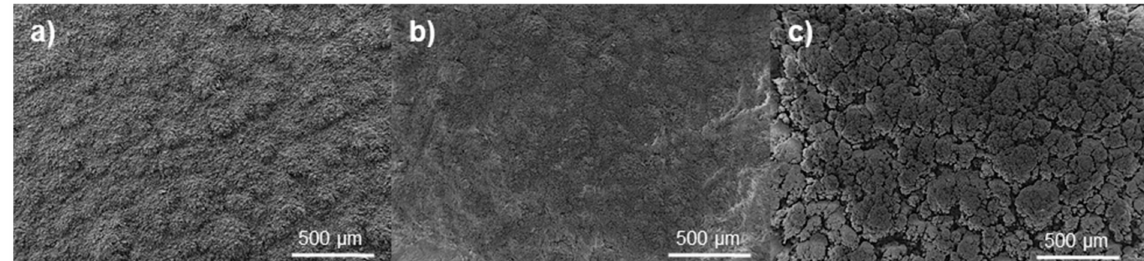
Figure 1. Surface micrographs of different suspension plasma spraying (SPS) coatings: ( a ) Al 2 O 3 /TZ-3YS; ( b ) SiC-reinforced Al 2 O 3 /TZ-3YS; ( c ) SiC-reinforced Al 2 O 3 /TZ-3YS with fructose.